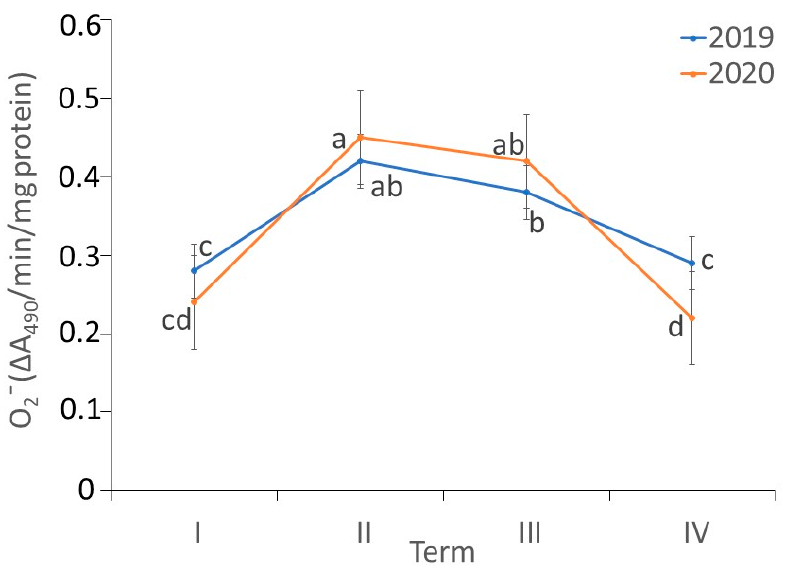
Figure 4. Changes in the superoxide anion radical (O 2 ¯) content ( Δ A 490 /min/mg protein) in A. fabae fundatrigeniae during feeding on V. opulus (means ± SD; n = 4). Different letters denote significant differences (one–way ANOVA; Tukey’s test; p < 0.05).